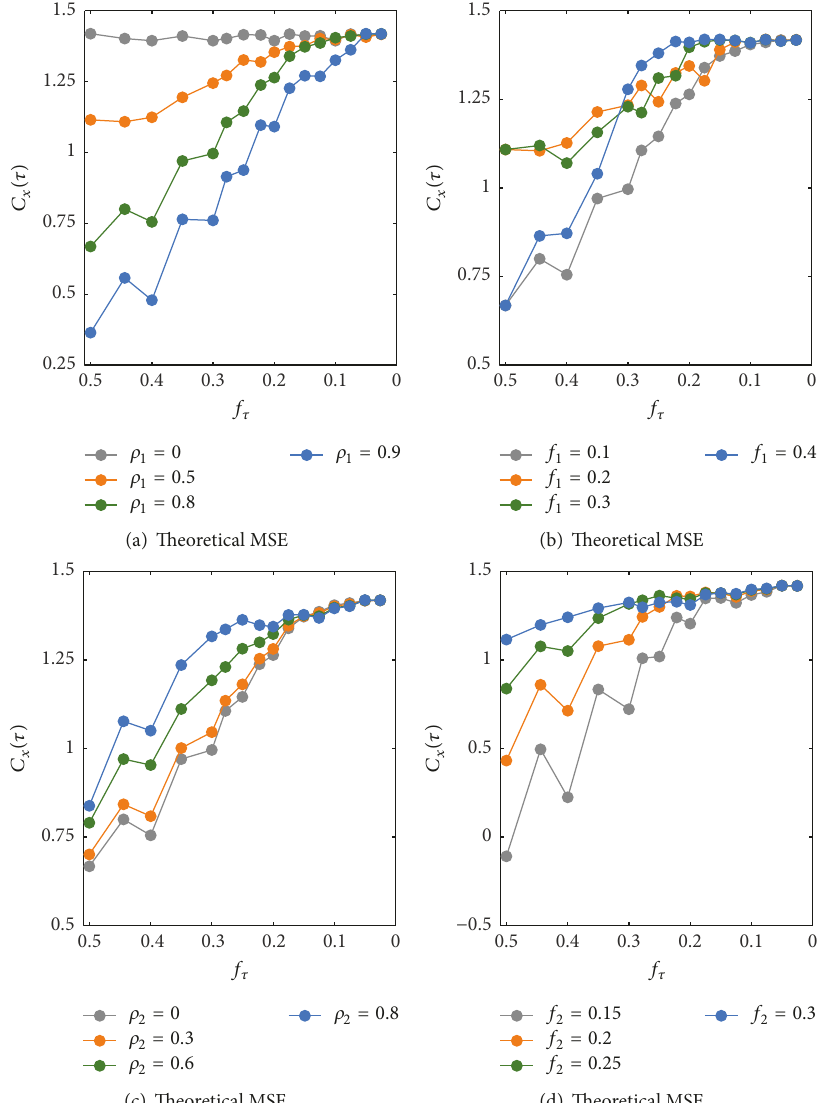
Figure 1: Theoretical profiles of the multiscale entropy (MSE) computed applying the proposed approach to the true parameters of simulated AR processes. Plots depict the exact values of MSE ( 𝐶 𝑥 (𝜏 𝑠 ) ) computed as a function of the cutoff frequency of the low-pass filter used to ) for different values of the modulus 𝜌 𝑓 eliminate the fast temporal scales of the process (𝑓 𝜏 1 (a) and of the frequency 1 (b) of the pole set 𝑠 in Type 1 simulations, and for different values of the modulus 𝜌 2 (c) and frequency 𝑓 2 (d) of the second pole set in Type 2 simulations. The multiscale complexity of AR processes increases with decreasing the amplitude (a) or moving the frequency of a single stochastic oscillation closer to half the Nyquist frequency (b), as well as adding a second stochastic oscillation with increasing amplitude (c) or with increasing frequency mismatch compared to the first one